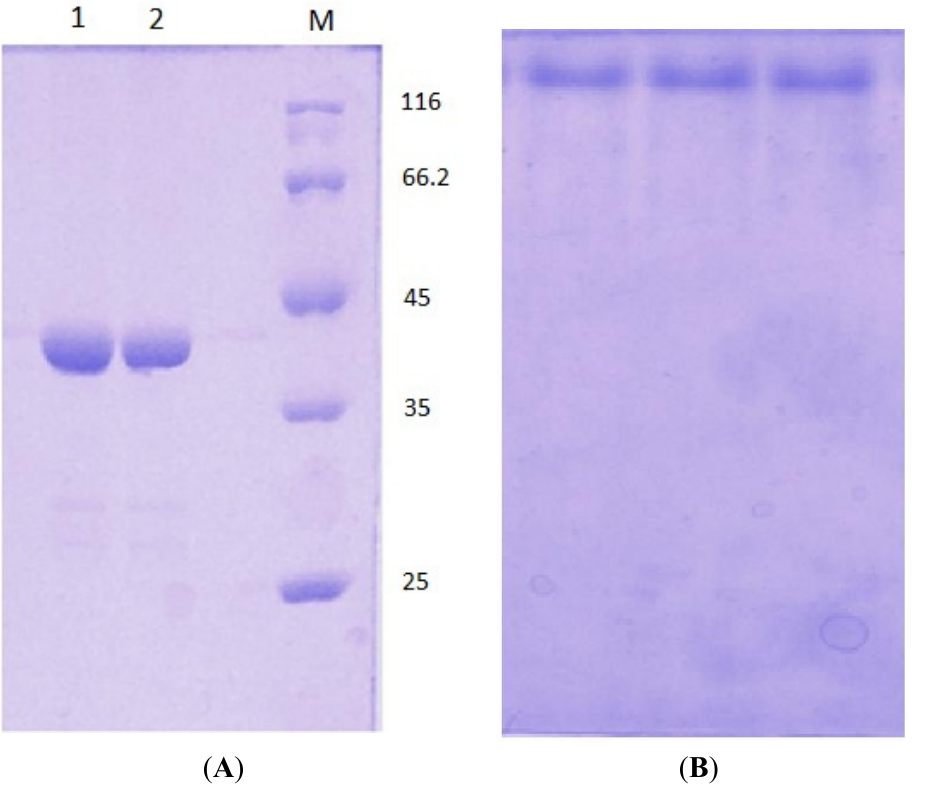
Figure 6. ( A ) SDS-PAGE (12%) of mutant lipase D311E. M: standard protein markers (kDa); purified lipase (lane 1 and 2); ( B ) Single band of D311E lipase on Native PAGE analysis after ion exchange